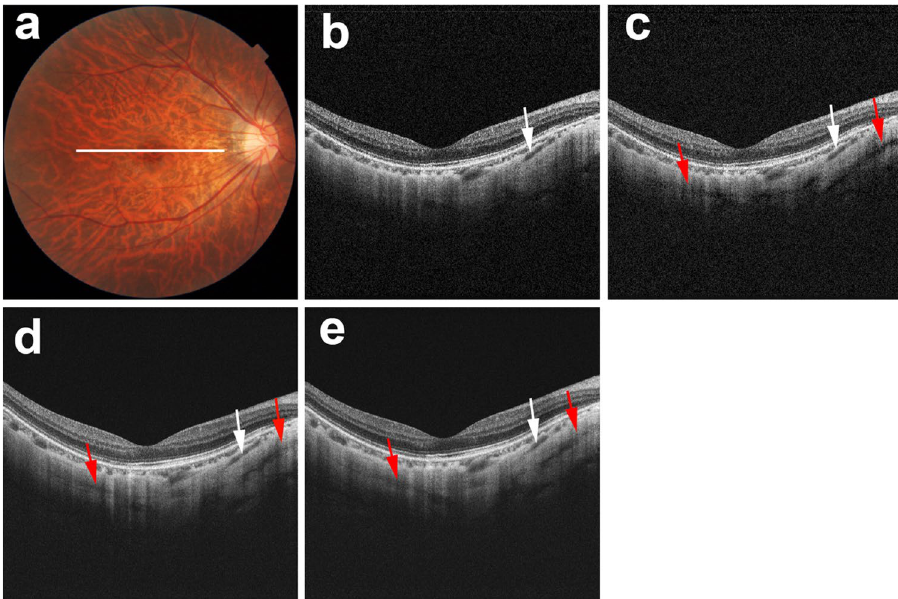
Figure 4. Scleral vessel artifacts in polarization-dependent OCT images and commercial OCT images in the same locations. The right eye of a 38-year-old woman with pathologic myopia is shown. White line in color fundus image ( a ) indicates the scan line for PD-OCT images and commercial OCT B-scan images ( b – e ). Polarization-independent OCT B-scan image ( b ) shows a real scleral vessel (white arrow). Polarization- dependent OCT B-scan image ( c ) and two repeated commercial OCT B-scan images ( d , e ) also show real scleral vessels (white arrows). Along with the real scleral vessel, polarization-dependent OCT B-scan image ( c ) shows scleral vessel artifacts (red arrows). Two repeated commercial OCT B-scan images ( d , e ) also show scleral vessel artifacts (red arrows) in locations similar to the locations in polarization-dependent OCT